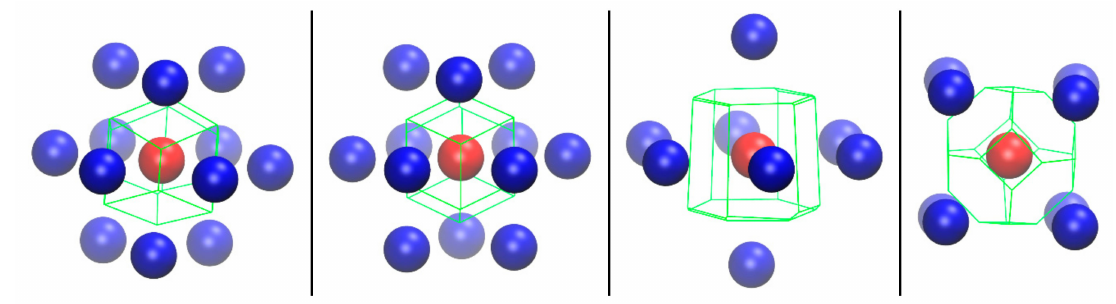
Figure 8. Snapshots of local environments, as generated through present MC simulations, showing very high similarity to a specific reference X -crystal, as quantified by the corresponding very low value of the X -CCE norm. From left to right: HCP-like ( ε HCP = 0.0340); FCC-like ( ε FCC = 0.0223); HEX-like ( ε HEX = 0.0466); BCC-like ( ε BCC = 0.0536). Reference site and nearest neighbors are shown in red and blue, respectively. Also shown are the corresponding Voronoi polyhedra as green lines. Sites are shown with reduced diameter in a 2:5 scale for visualization purposes. Image created with the VMD software. Each figure panel is also available as stand-alone image in 3-D, interactive format in the Supplementary